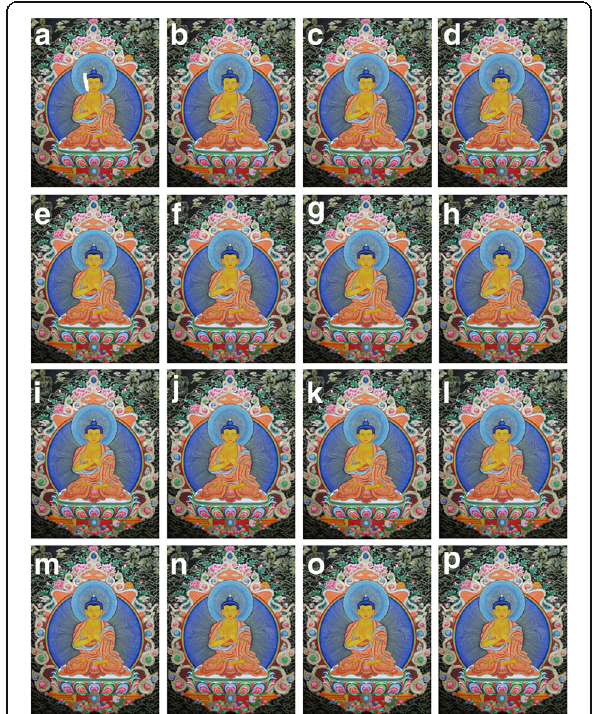
Fig. 9 Left ear damage of Dipamkara and inpainting results based on eight-direction symmetrical exemplars and patch ’ s different sizes. a Damaged image. b 3 × 3. c 15 × 15. d 17 × 17. e 19 × 19. f 21 × 21. g 25 × 25. h 27 × 27. i 31 × 31. j 35 × 35. k 37 × 37. l 39 × 39. m 41 × 41. n 43 × 43. o 45 × 45. p 47 × 47